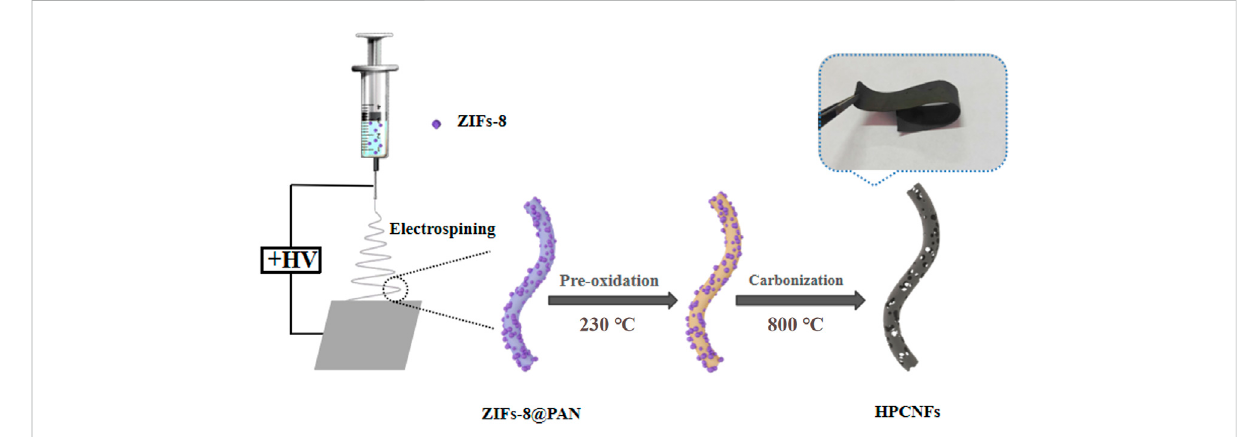
FIGURE 1 Schematic illustration for the preparation process of the